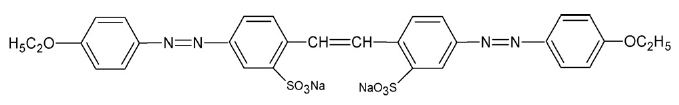
Figure 1. The structure of direct yellow